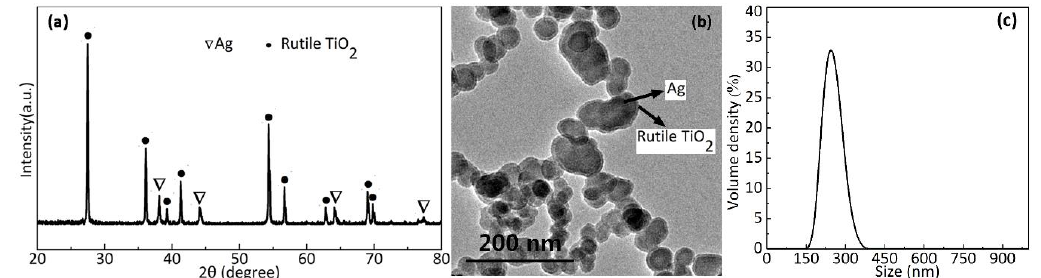
Figure 2. ( a ) X-ray diffraction (XRD) patterns from Ag/TiO 2 core-shell nanoparticles (NPs) with different surfactants, ( b ) TEM image of Ag/TiO 2 core-shell NPs, and ( c ) the size distribution of Ag/TiO 2 core–shell NPs.